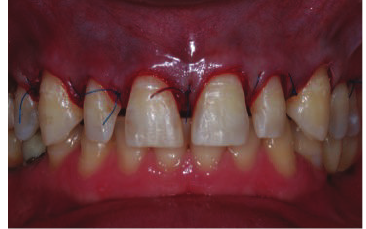
Figure 12: Suture of the surgical region.